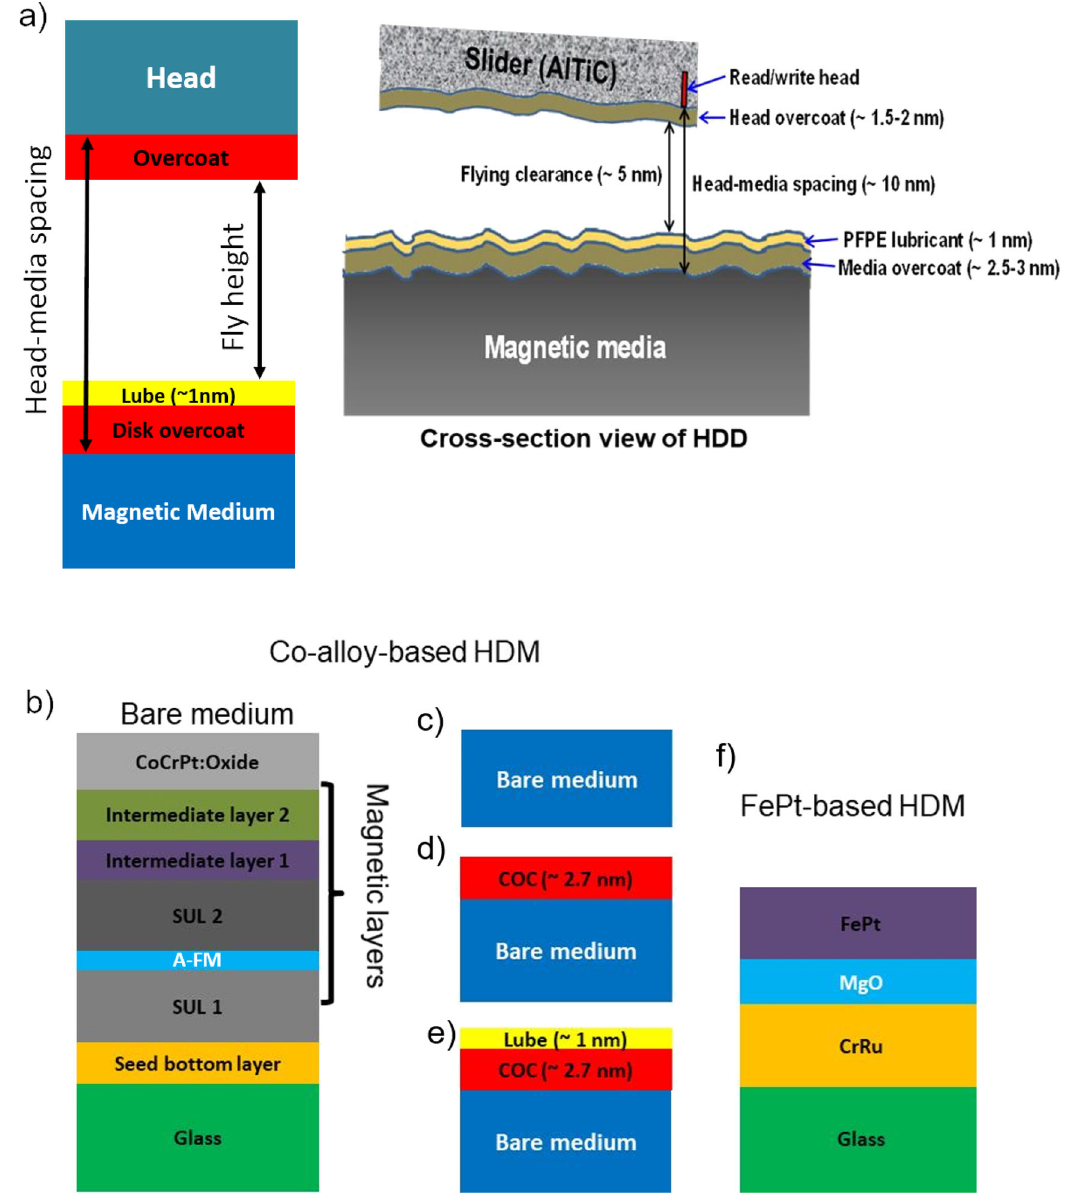
Fig. 1 Hard disk media structures. a Schematic cross-section of a hard disk drive with magnetic medium, disk overcoat, lubricant, fl y height, head overcoat, head. The head-medium spacing and fl y height/clearance are indicated by arrows. The slider containing the read/write head and the head overcoat are shown as well. For 1 Tb/in 2 , the head-media spacing is ~8.9 – 6.5 nm 6 , based on the sum of overcoat thickness (2.5 – 2 nm) 6 , lubricant thickness (1.2 – 1 nm) 6 , touch down height (2 – 1 nm) 6 , fl y clearance (1.2 – 1 nm) 6 and head overcoat thickness (2 – 1.5 nm) 6 . b Full stack of bare CoCrPt:Oxide-based hard disk media intermediate layers and a co-based magnetic recording layer. c Bare medium (BM). d Magnetic medium with ~2.7 nm commercial COC. e Magnetic layer of CrRu followed by layers of MgO and